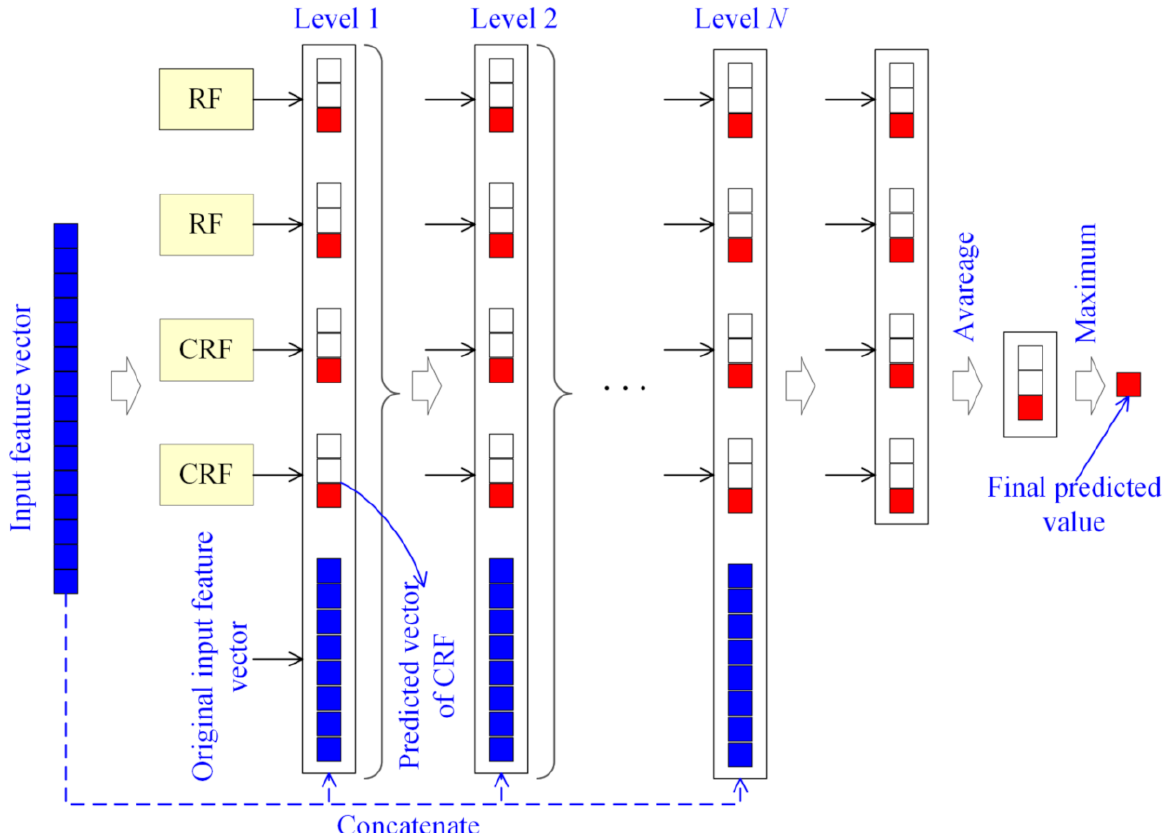
Figure 2. Schematic diagram of cascade